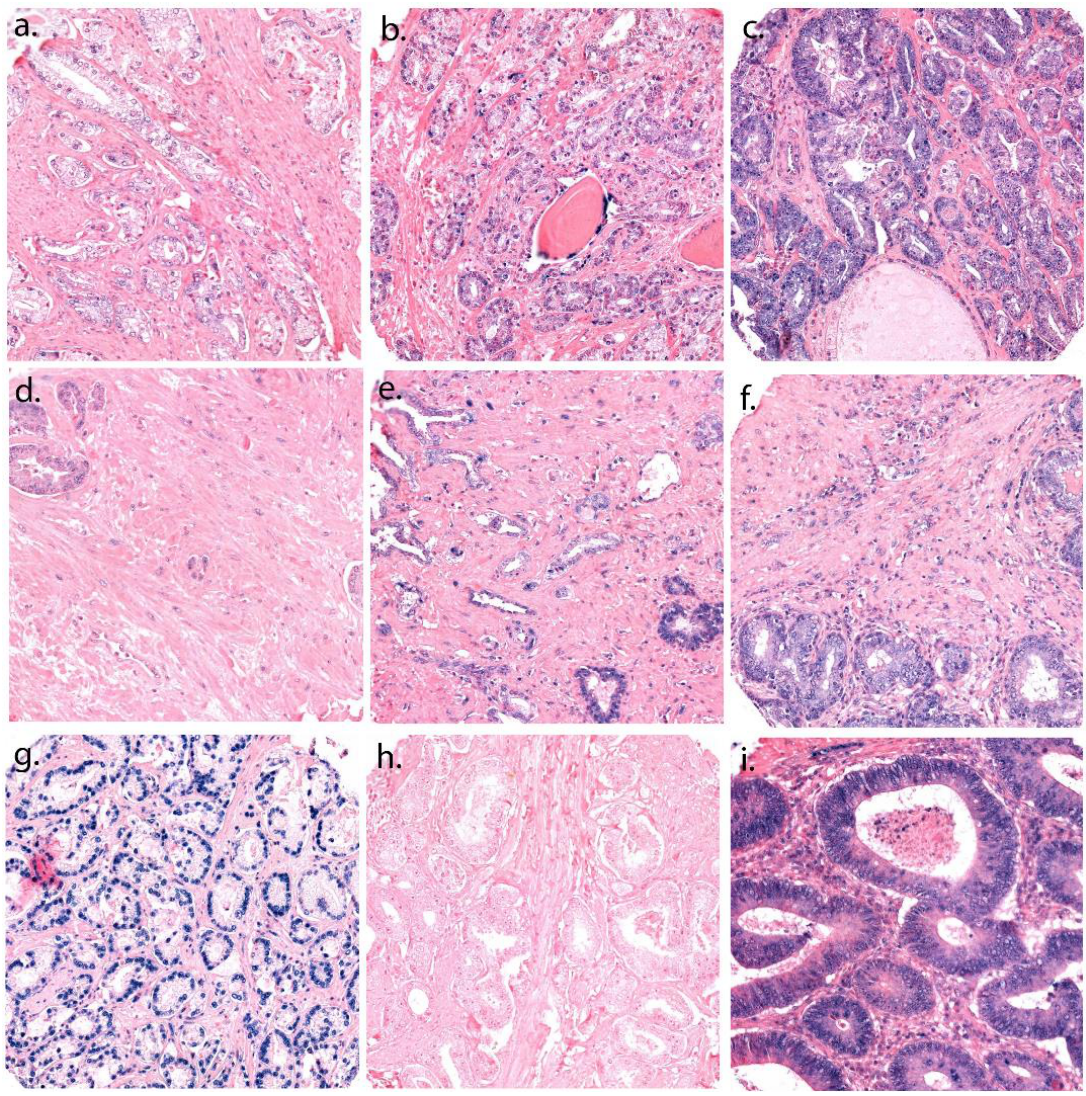
Figure 1. A panel of ISH stained cores; representative scorings of miR-20a-5p in tumor epithelium (TE) and tumor stroma (TS). TE is given a value from 0 to 3, depending on the intensity of the staining in both core and cytoplasm of the TE. TS is given a value from 0 to 3, depending on the density of positive TS cells in the examined core. ( a – c ) Score 1 – 3 in TE; ( d – f ) Score 1 – 3 in TS; ( g ) U6 control staining; ( h ) Scramble miR; ( i ) Positive tissue control: normal human colon tissue, 20× magnification.